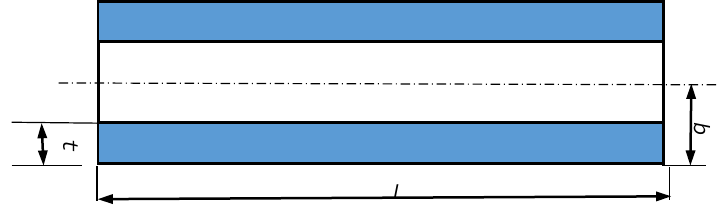
Figure 3. Composite milling bar ( b = 15.875 mm, t = 11.1125 mm). Table 1. Properties of composite materials [30].